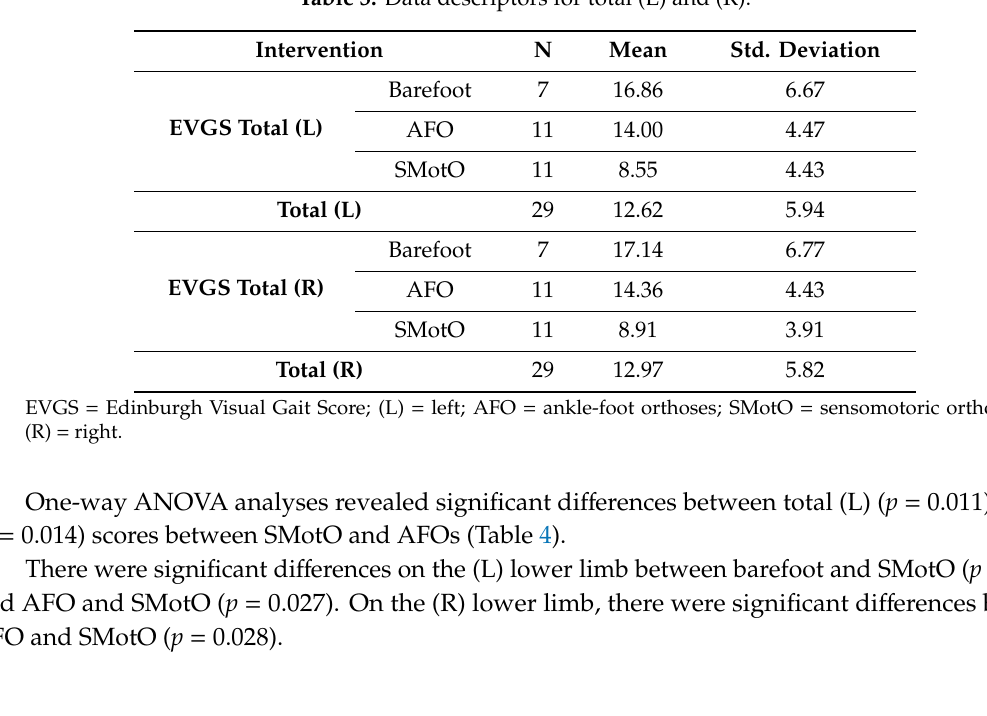
Table 3. Data descriptors for total (L) and